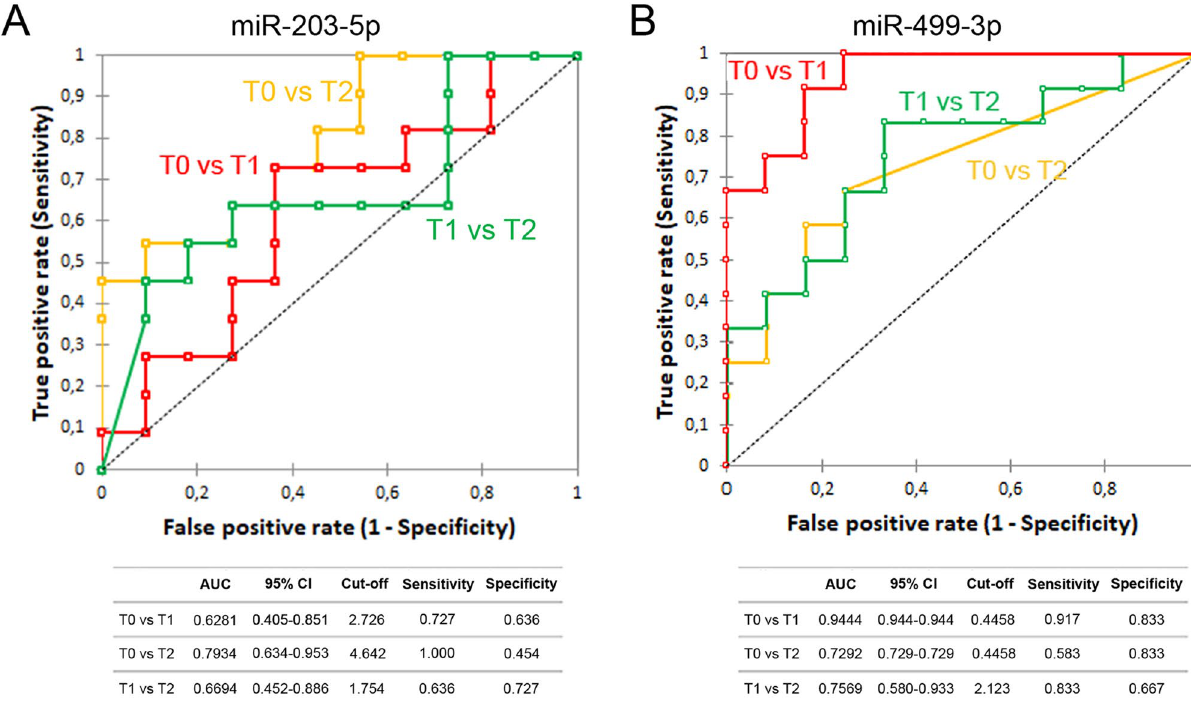
Figure 3. Receiver-operator characteristic (ROC) curve analysis of DE-miRNAs. AUC, area under the curve; CI, confidence interval. T0 = pre-surgery; T1 = 2.5 h post-surgery; T2 = 36 h